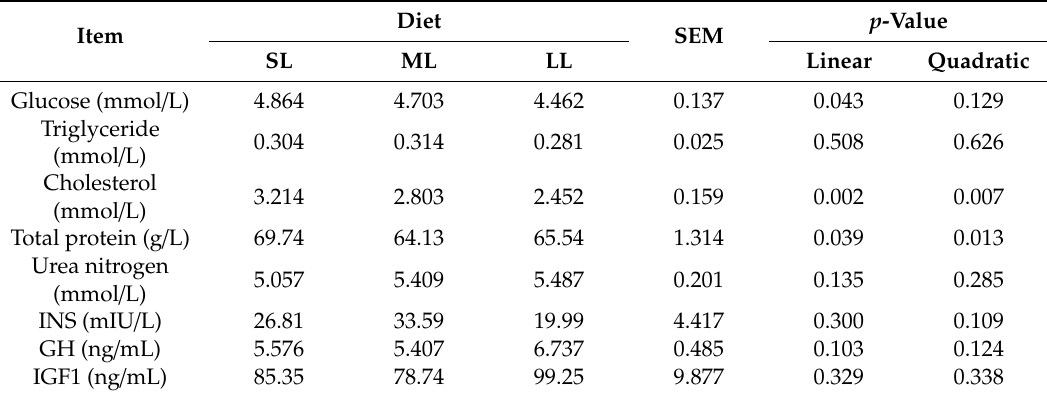
Table 4. E ff ects of roughage length on the plasma parameters of weaned